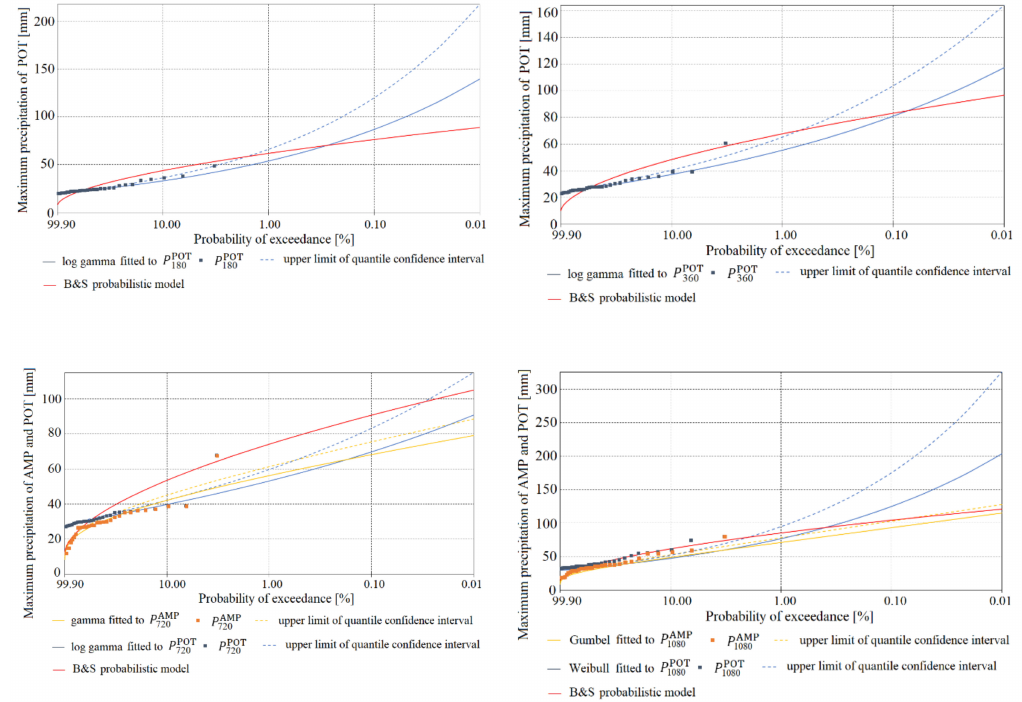
Figure 6. Plots of functions of probability of exceedance for the random variables P AMP τ and/or P POT τ , where τ = {180, 360, 720, 1080} min, for the most credible probability distributions, with indication of upper limits of quantile confi- dence intervals according to the PMAXTP method, compared with the model of Bogdanowicz and Stach ý , for the Chojnice meteorological